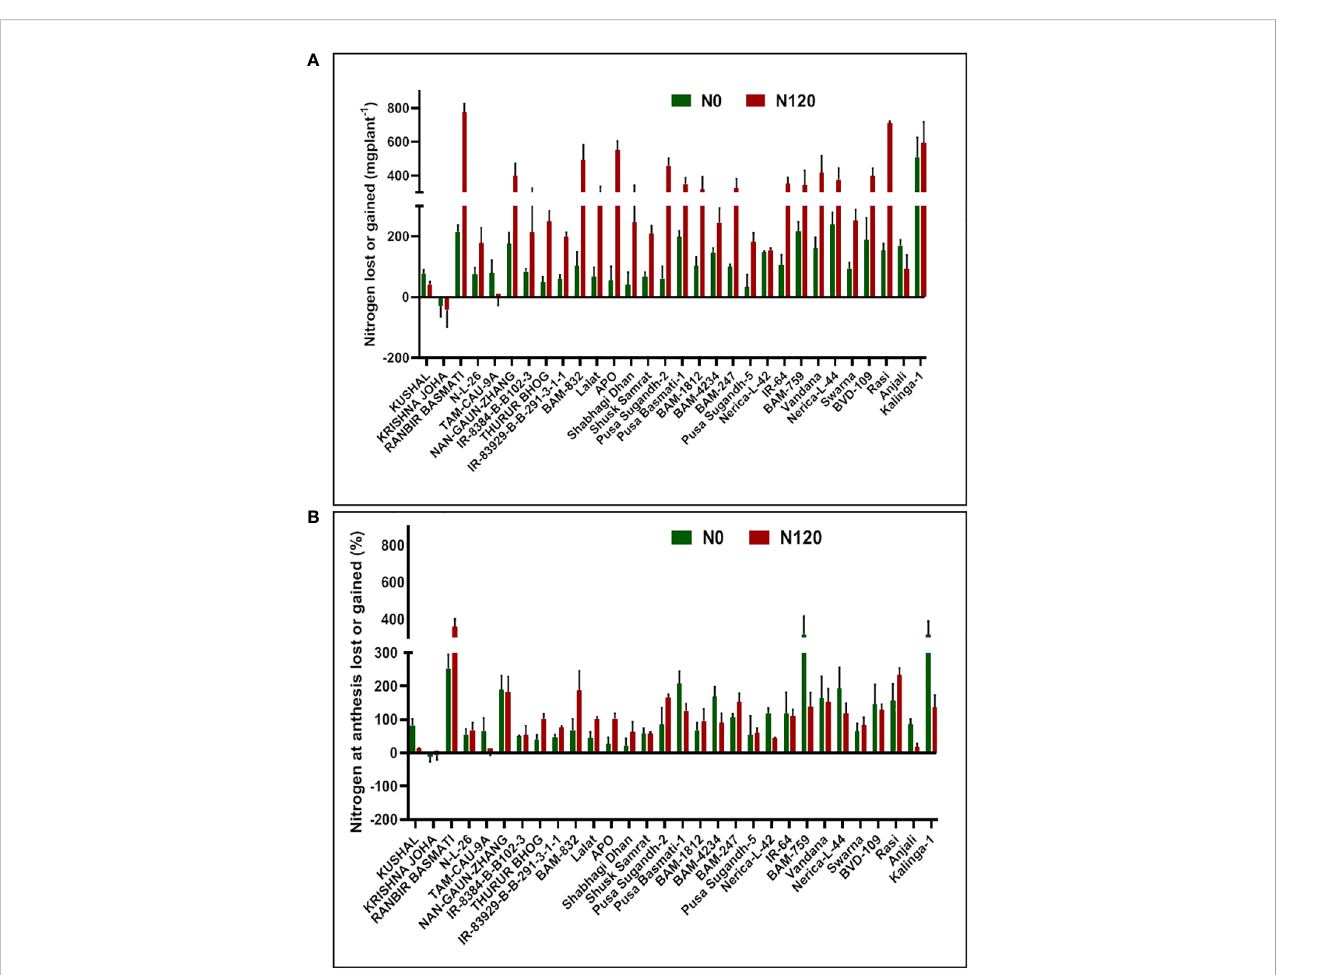
FIGURE 10 Effect of nitrogen de fi cient (0 kg ha -1 fertilizer N: N0) and nitrogen suf fi cient (120 kg ha -1 fertilizer N: N120) fi eld conditions on (A) nitrogen lost or gained and (B) nitrogen at anthesis lost or gained in fi eld-grown diverse rice genotypes during the 2019- kharif season. Values presented are Mean ± SE with three